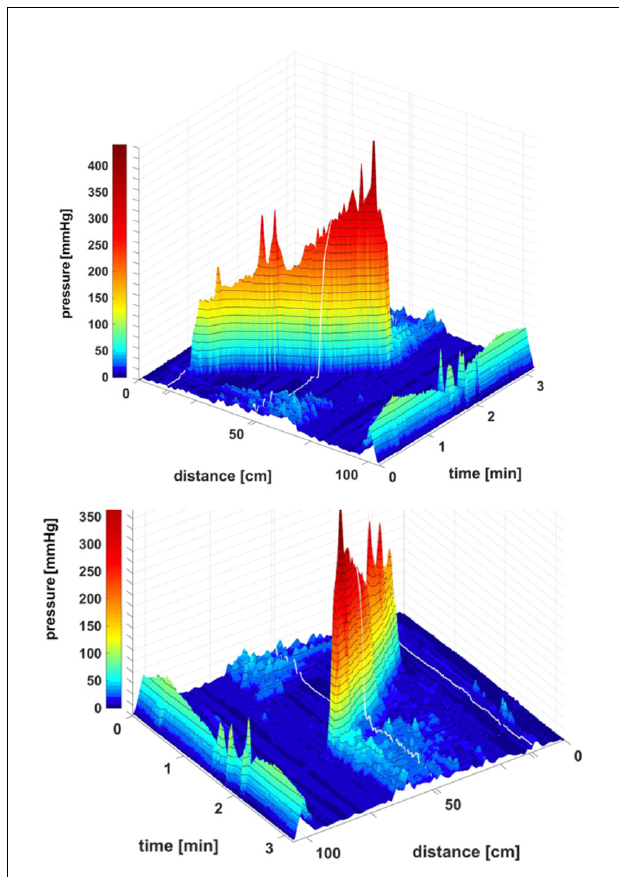
FIGURE 7 | An HAPW that was not followed by an SPW, was not associated with anal sphincter relaxation. Most HAPWs that are associated with anal sphincter relaxation terminate into an SPW that enters the anal canal. In this subject, an HAPW that terminated suddenly and was not followed by an SPW and did not evoke anal sphincter relaxation. This motor pattern occurred 4 min into a proximal balloon distention (240 ml air). The motor pattern started distal to the balloon